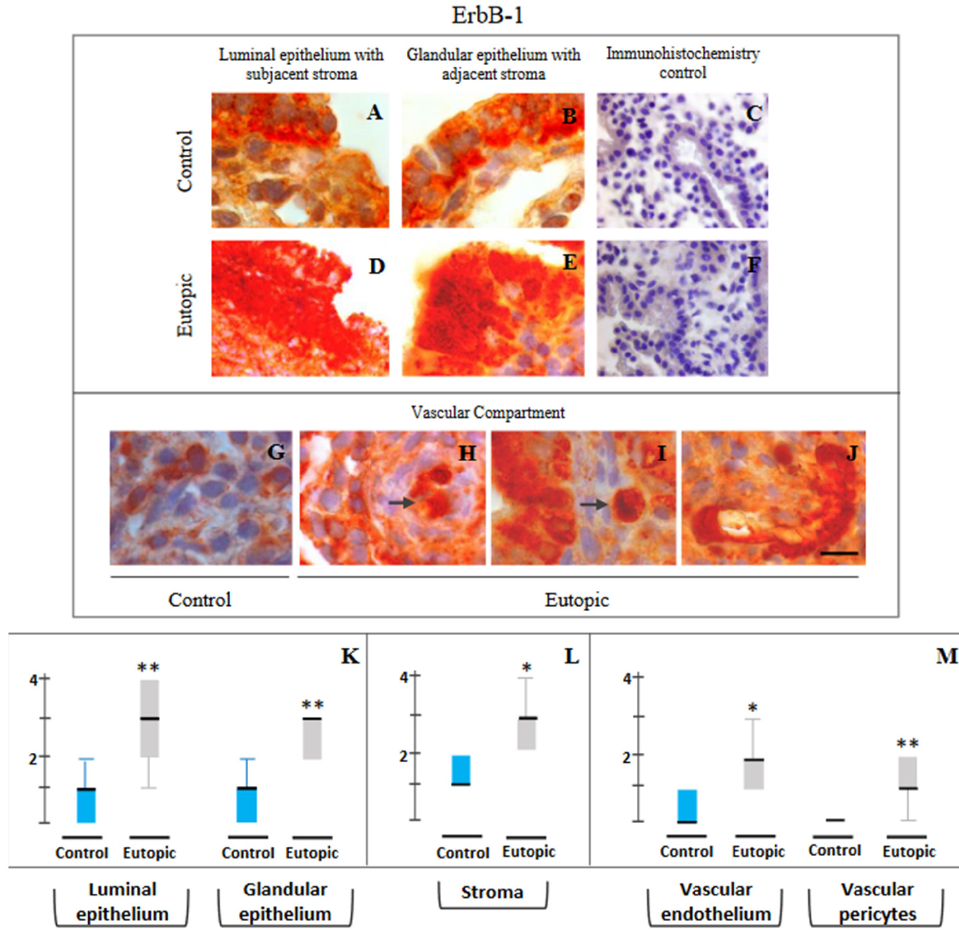
Figure 2. Representative photomicrographs of ErbB-1 ( A – J ) expressions in luminal epithelium along with subjacent stroma ( A , D ), glandular epithelium along with adjacent stroma ( B , E ) and in cells of the vascular compartment ( G – J ) in endometrial samples collected from endometriosis-free control women of group 1 ( A – C , G ) and stage IV ovarian endometriosis patients of group 2 ( D – F , H – J ). Semi-quantitative assessments of immunopositivity scores are shown in the form of box plots of 10–90 percentile distribution of scores, along with median values ( K – M ). Markedly higher ErbB-1 immunostaining is seen in the luminal and glandular epithelium and in stromal cells of endometrium obtained from group 2 subjects, i.e., infertile patients with stage IV ovarian endometriosis ( D , E ), as compared to control endometrium obtained ( A , B ) from endometriosis-free control women (group 1). High levels of cytoplasmic distribution besides membranous localization of ErbB-1 are seen, more predominantly in eutopic endometrial epithelium ( D , E ). Minimal immunopositivity is seen in endothelial cells and pericytes of control endometrium ( G ), while endothelial cells and pericytes of eutopic endometrium obtained from patients with severe endometriosis show strong immunostaining for ErbB-1 ( H – J ). Intravascular ( H ) and extravascular ( I ) monocytes in eutopic endometrium showed moderate to high immunoprecipitation (shown as arrows). This feature was generally absent in control endometrium obtained from disease-free control patients. Marked cytoplasmic and nuclear distribution besides membranous localization are notable for ErbB1 ex- pression in eutopic endometrium of stage IV ovarian endometriosis infertile patients. Controls for immunohistochemistry staining were attained by omitting the primary antibody ( C ) or the secondary antibody ( F ). * p < 0.02. ** p < 0.01. Bar: 20 µ m ( A , B , D , E , G – J ), 100 µ m ( C , F